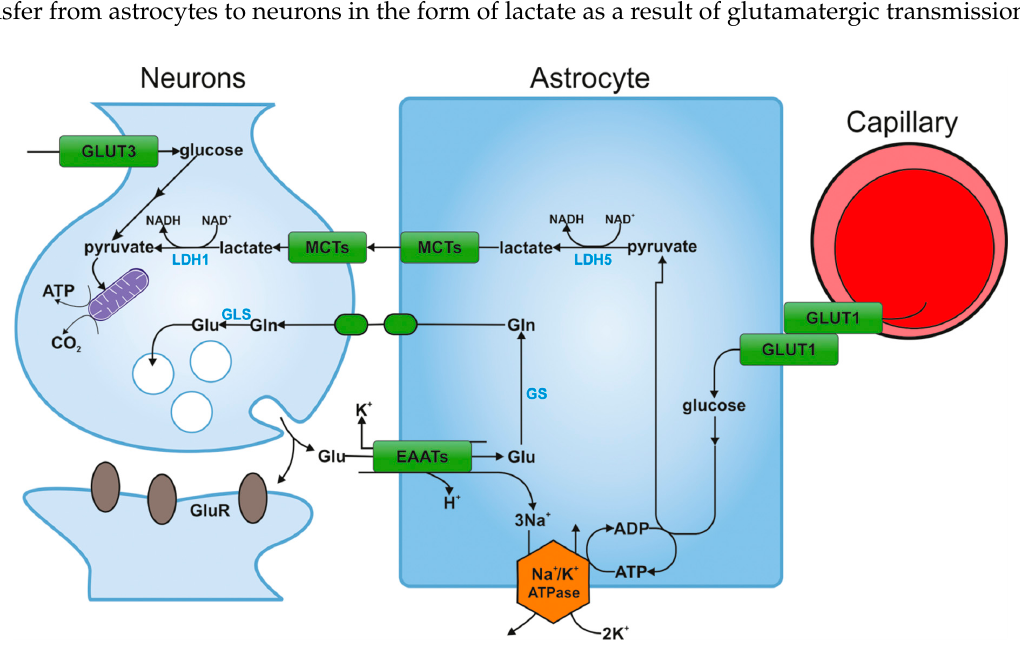
Figure 4. The hypothesis of astrocyte-neuron lactate shuttle [16]. Glucose is transported from blood vessels to astrocytes by endothelial cells. After entering the astrocyte via GLUT1, part of the glucose is metabolized to lactate via pyruvate by the isoenzyme of lactate dehydrogenase (LDH5). Then lactate is transported outside the astrocyte through the MCT transporter and is captured by neurons, also via the MCT transporter. Intracellular lactate in the neuron is oxidized to pyruvate by the other isoenzyme of lactate hydrogenase (LDH1) and is metabolized along the oxygen pathway. Glucose may be also transported directly into neuronal cells and penetrates into these cells via GLUT3. GLUT1, GLUT3: glucose transporters; MCT: monocarboxylate transporter; TCA: Krebs cycle; GS: glutamine synthetase; Glu: glutamate; Gln: glutamine; GluR: receptor for glutamate; EAATs: excitatory amino-acid transporters; GLS: glutaminase; LDH1, LDH5: isoenzymes of lactate